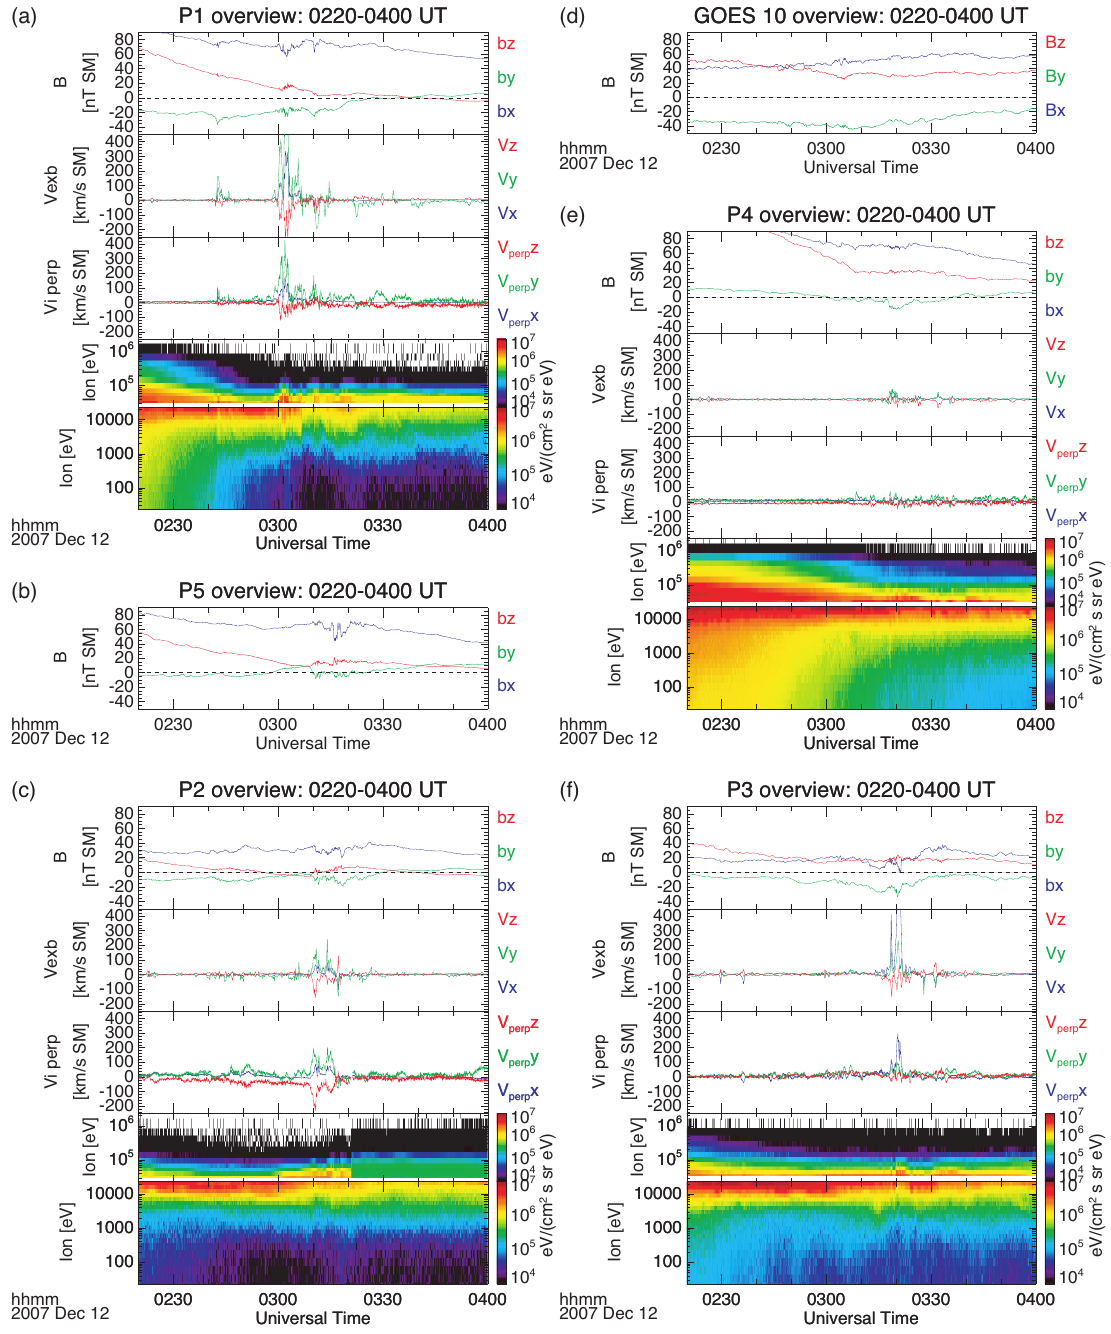
Fig. 2. An overview of THEMIS and GOES 10 observations and geomagnetic field variations at 02:20–04:00UT on 12 December 2007. Panels for (a) THEMIS P1, (c) P2, (f) P3, and (e) P4 include the magnetic field, E × B velocity, joint ion velocity (obtained from both ESA and SST instruments), and ion E − t diagrams. Panels for (b) THEMIS P5 and (d) GOES 10 show magnetic field observations.